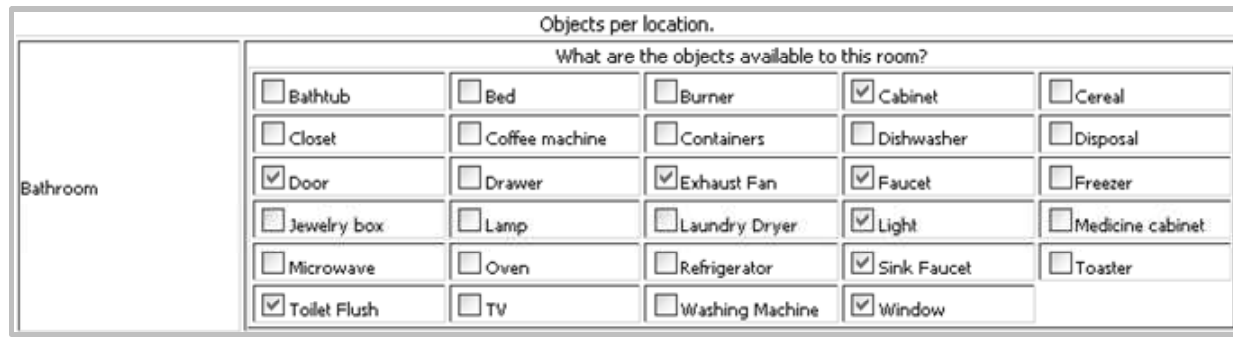
Figure 4. Testbed configuration: object selection interface.